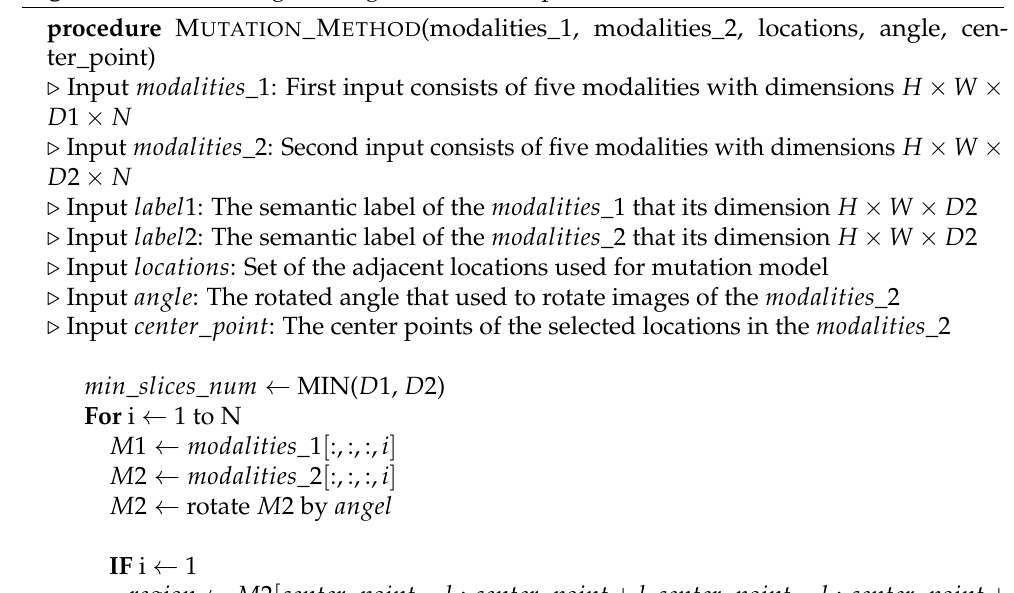
Algorithm 5 Mutate regions to generate new